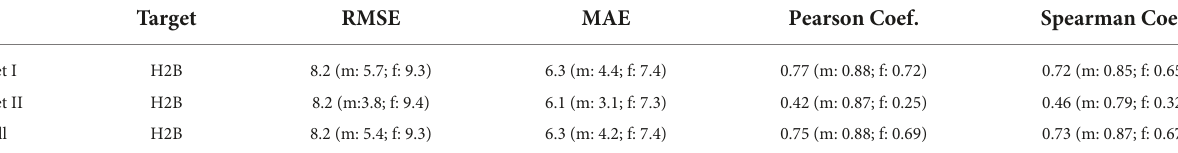
TABLE 4 The accuracy of the depression prediction, when the H2B scores were used for training. Target RMSE MAE Pearson Coef. Spearman Coef.